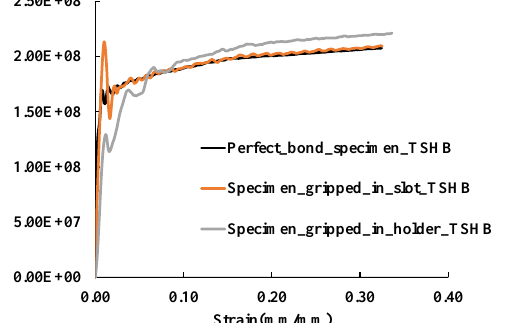
Fig. 12. Comparison of shear stress-strain from three cases using TSHB analysis